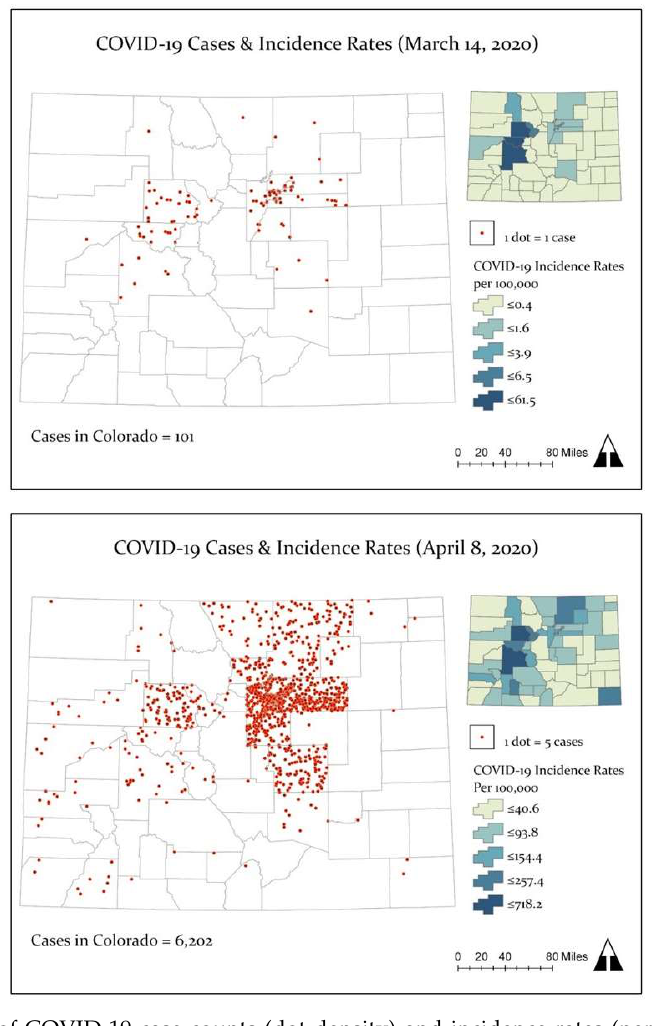
Figure 2. Maps of COVID-19 case counts (dot density) and incidence rates (per 100,000 persons) across counties in Colorado on March 14, 2020 (top panel) and April 8, 2020 (bottom panel). Source: CDPHE [6,20]